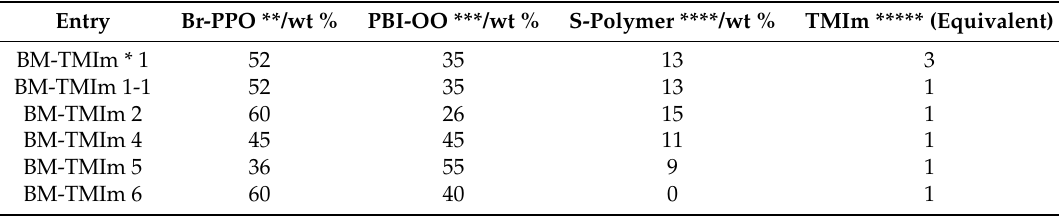
Table 1. The compositions of the anion-exchange blend